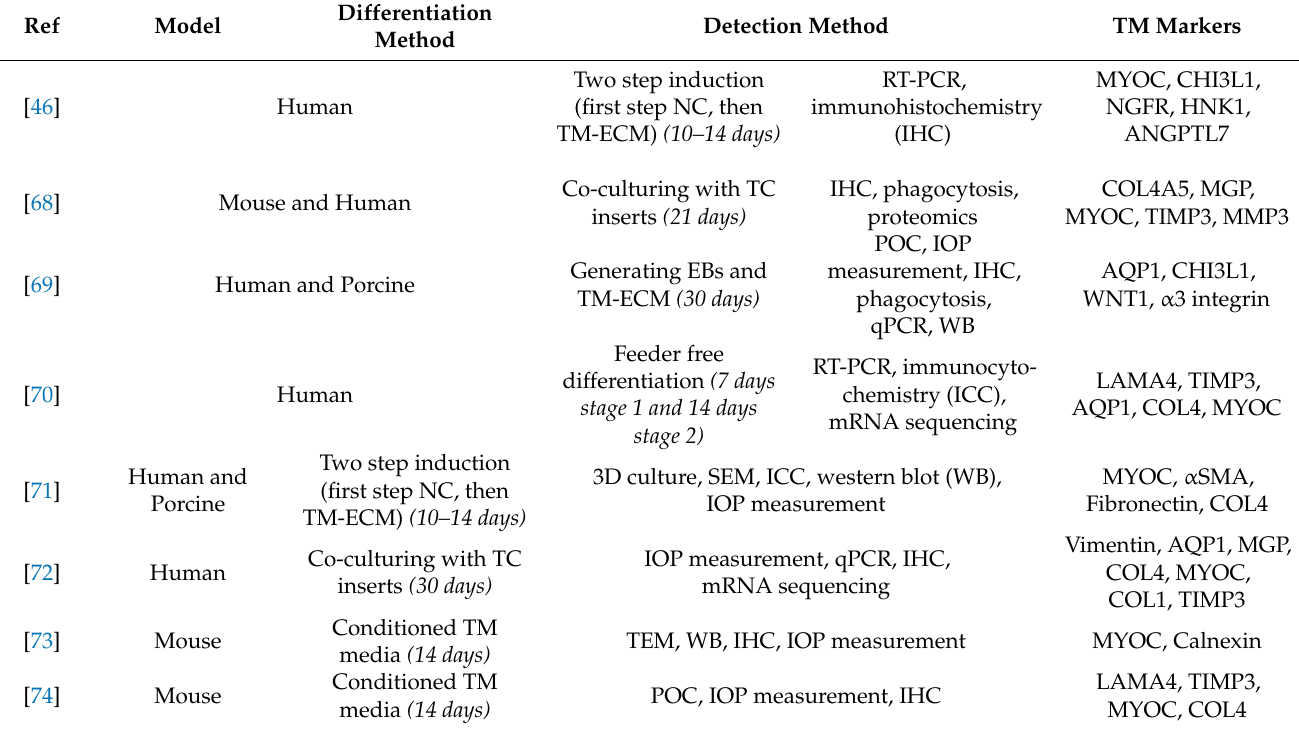
Table 4. Methods of iPSC differentiation into TM cells and TM cell-specific markers and detection methods. Ref